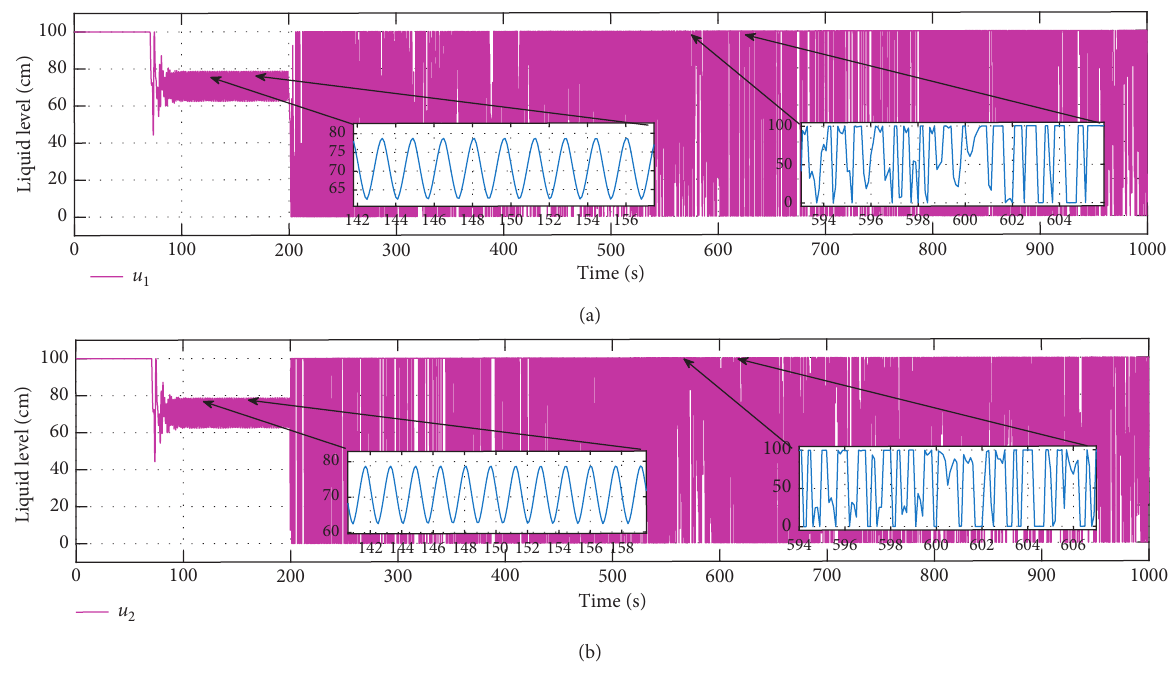
Figure 5: Inputs under the finite-time control with disturbances.